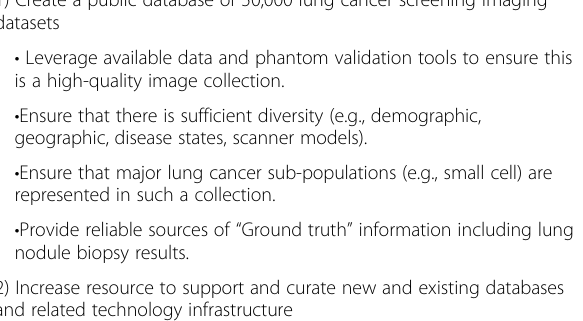
Table 1 Consensus aspirations for advancing quantitative imaging to improve lung cancer screening and quantitative tool development and